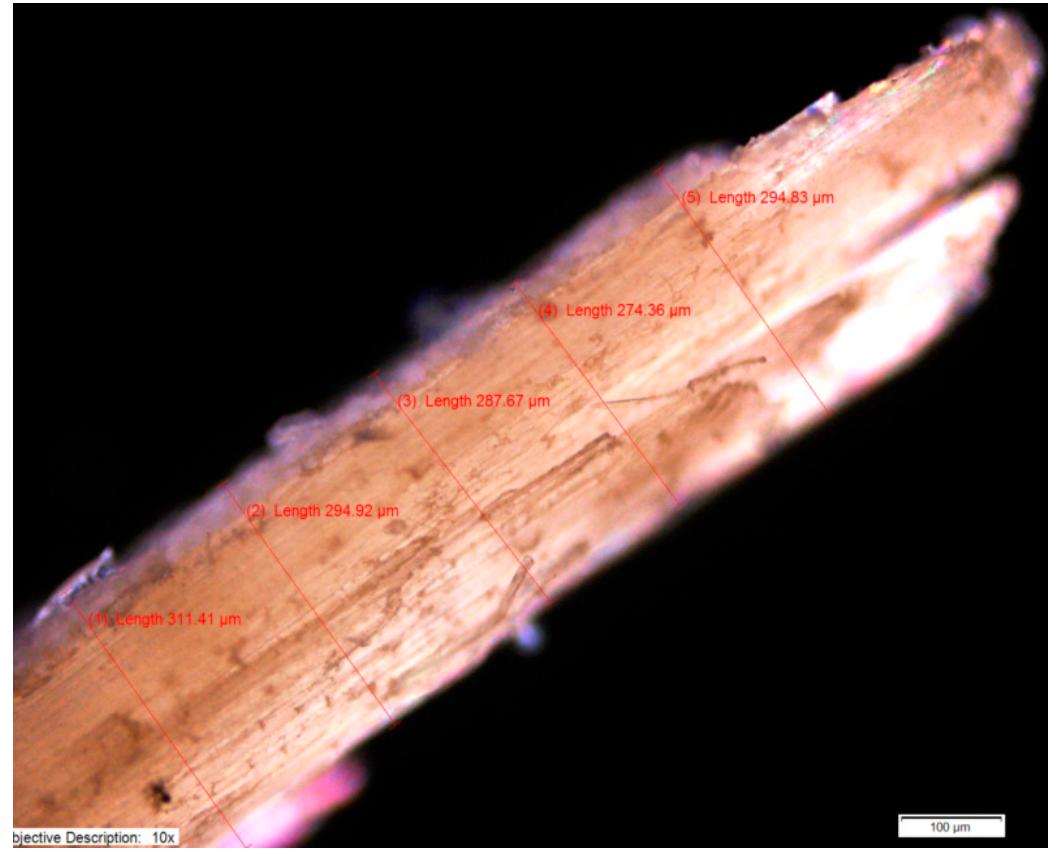
Figure 5. SEM image of fractured section of a bamboo fiber with tentative measurement of diameter.